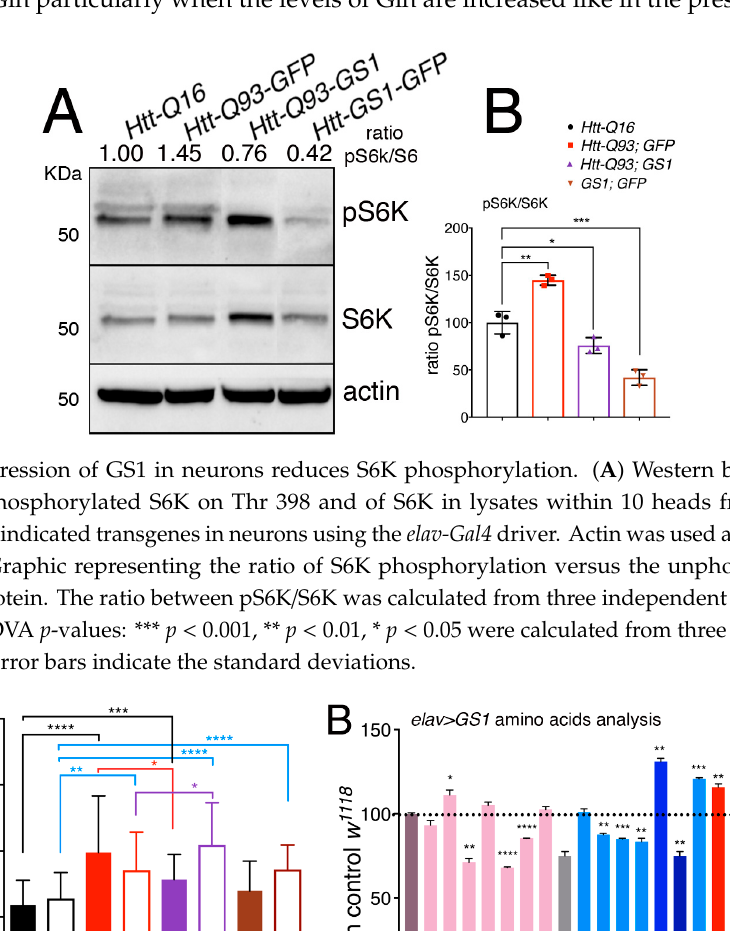
(Figure 7A solid black vs. brown columns, t -test ns) but significantly increased the levels of Gln (Figure 7A, empty black vs. empty brown columns, t -test P < 0.0001). Suggesting that GS1 is able to convert Glu into Gln particularly when the levels of Gln are increased like in the presence of Htt-Q93.